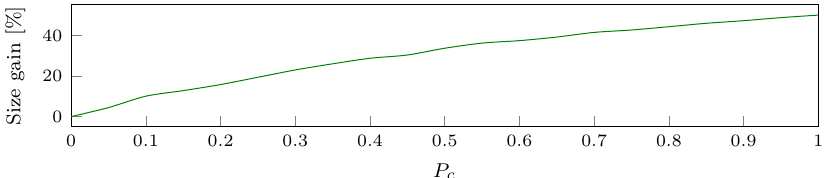
Figure 6. Size gain of the OpQHL compared to the initial QHL, for a varying probability P c of having MKUs that can be consolidated. Where P c = 0 means that no consolidation is happening and P c = 1 means that each MKU in the dataset can be consolidated